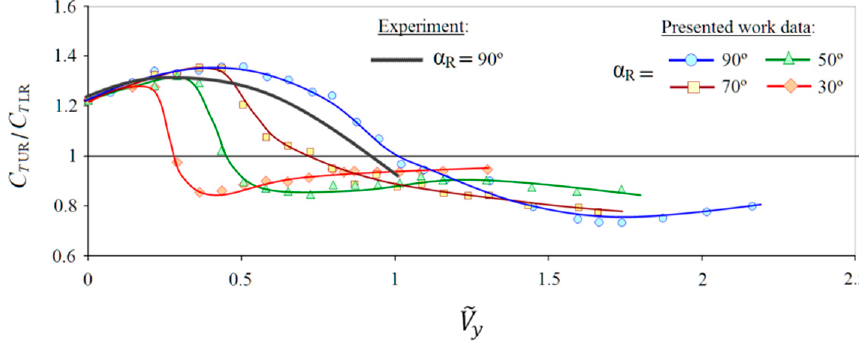
Figure 13. Calculated and experimental [7] dependencies of C T UR / C T LR = f( (cid:101) V y ) at α R = 30–90 ◦ . With the increase in the required power in the VRS modes, a significant increase in the induced velocity of the rotor is observed; it reaches two–three times that of the hovering mode. Usually, the results of experimental and numerical studies of the VRS modes include the dependencies of the non-dimensional induced velocity (cid:101) υ y of the rotor on the non-dimensional vertical descent speed (cid:101) V y . Such dependencies for the considered modes are shown in Figure 14. The dependence of (cid:101) υ y = f( (cid:101) V y ) for α R = 90 ◦ (see Figure 14a) had been previously obtained in [29], and the dependencies for α R = 70, 50 and 30 ◦ (see Figure 14b–d) have been obtained in the presented study. Taking into account the thrust pulsations, this diagram can be represented as an area, as shown in Figure 14. An increase in the induced velocity (cid:101) υ y above a threshold value can also serve as one of the criteria for the VRS modes boundary. In addition to the calculated curves (cid:101) υ y = f( (cid:101) V y ), Figure 14 also shows a number of experimental dependencies obtained by various authors [6,7,10–12,16,17]. These are experiments performed for different conditions, different types and sizes of rotors and various experimental rigs. In [7], a model of a coaxial rotor in the WT has been studied, in [6,12], a model of a single rotor has been installed on a moving track and, in [11], rotors with a large blade twist (not typical for helicopter rotors) have been tested. For this reason, the experimental data have significant differences. Nevertheless, for all the angles of attack of the rotor, there is a good qualitative agreement between the calculation and the experimental data. Based on the analysis of the calculated data (Figure 14), we note that, with a decrease in the angle α R , the maximum time-averaged value (cid:101) υ y decreases and shifts to the left. Thus, at α R = 90 ◦ , the non-dimensional induced velocity reaches the value of (cid:101) υ y ≈ 2.3 at (cid:101) V y ≈ 1 (Figure 14a), at α R = 70 ◦ of the value of (cid:101) υ y ≈ 2 at (cid:101) V y ≈ 0.7 (Figure 14b), at α R = 50 ◦ of the value of (cid:101) υ y ≈ 1.6 at (cid:101) V y ≈ 0.45 (Figure 14c), and at α R = 30 ◦ of the value of (cid:101) υ y ≈ 1.4 at (cid:101) V y ≈ 0.3 (Figure 14d). The boundaries of the VRS modes for the criterion (cid:101) υ y > 1.5 observed within the limits are: (cid:101) V y ≈ 0.7–1.0 at α R = 90 ◦ , (cid:101) V y ≈ 0.7–1.0 at α R = 70 ◦ and (cid:101) V y ≈ 0.7–1.0 at α R = 50 ◦ . At α R = 30 ◦ , there is no VRS mode within the selected criterion (Figure